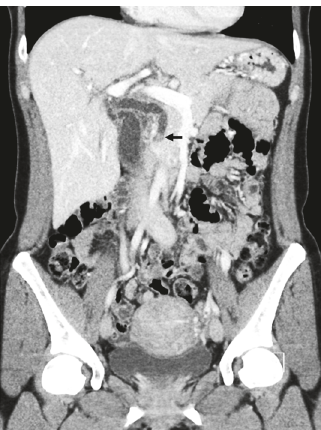
Figure 2: Case # 2, Dilated common bile duct with distal common bile duct stone (arrow), CT of Abdomen.